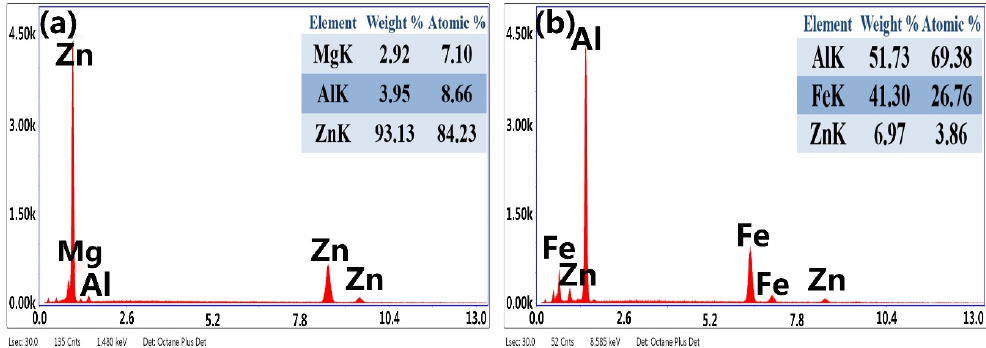
Figure 8. Element composition and relative content (at. %) of the overlay of the sample in different regions in Figure 7 (at. %). ( a ) Area 1, ( b ) Area 2.